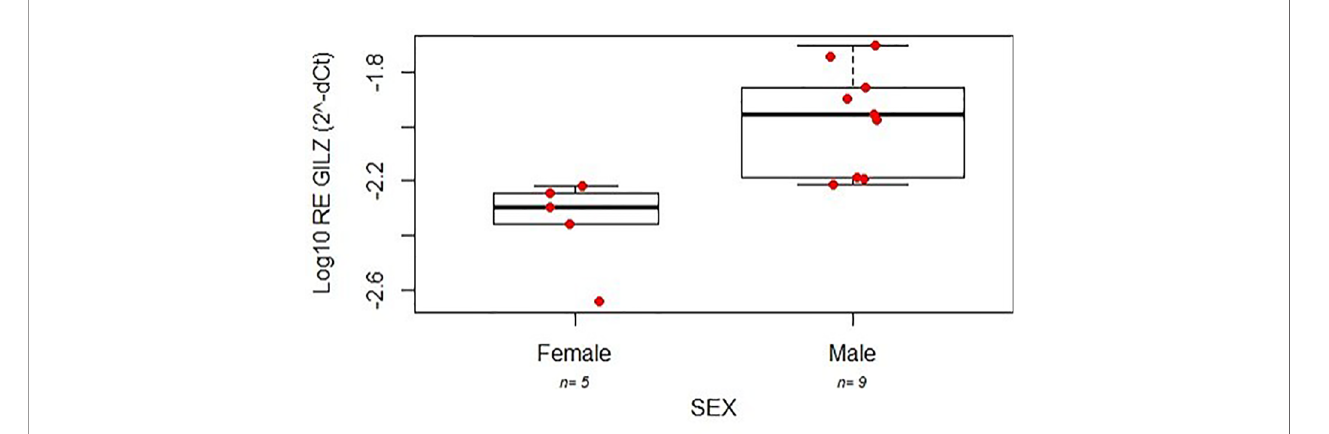
FIGURE 3 | Expression (relative log expression) of GILZ mRNA between the two genders affected by IBD.